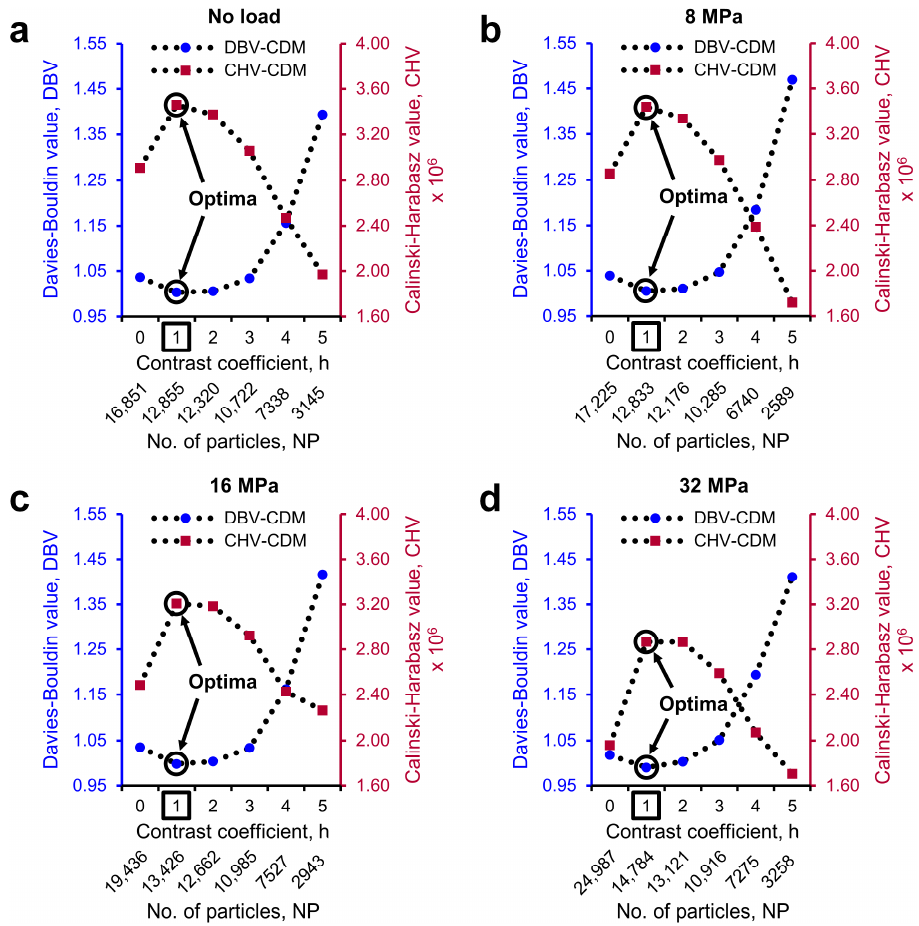
Figure 14. Variations of cluster evaluation values with the contrast coefficients ( h -values) of 0 to 5 for the sand volume subjected to one-dimensional compression loading of: ( a ) no load; ( b ) 8 MPa; ( c ) 16 MPa; and ( d ) 32 MPa. Circle marks on the plots and square marks on the X -axes show the optimal conditions.